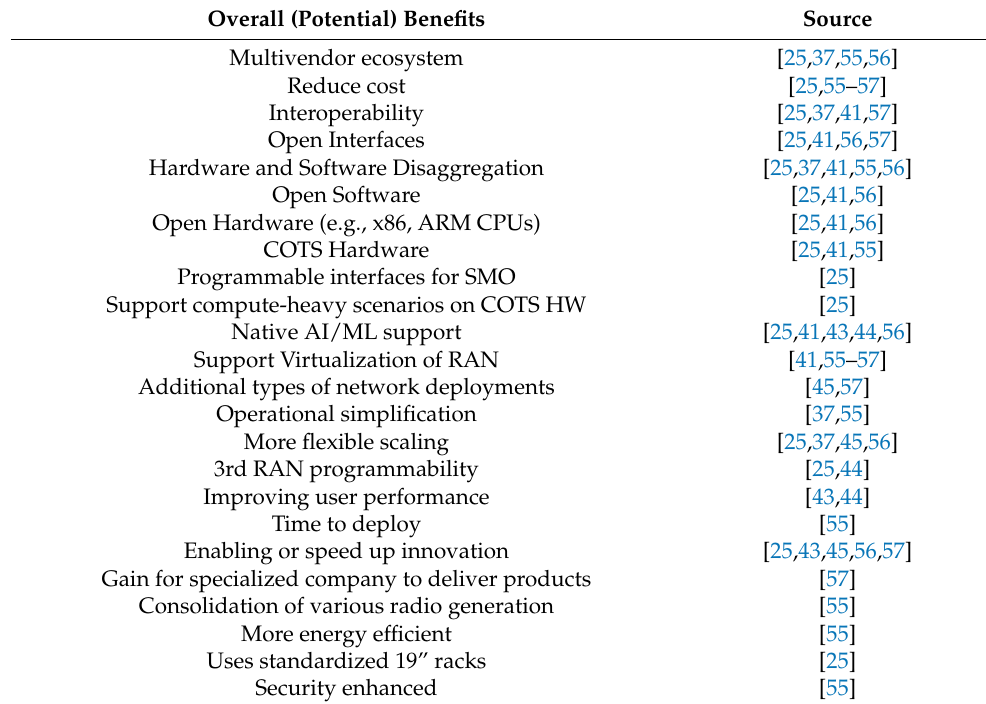
Table 3. Review of expected Open RAN